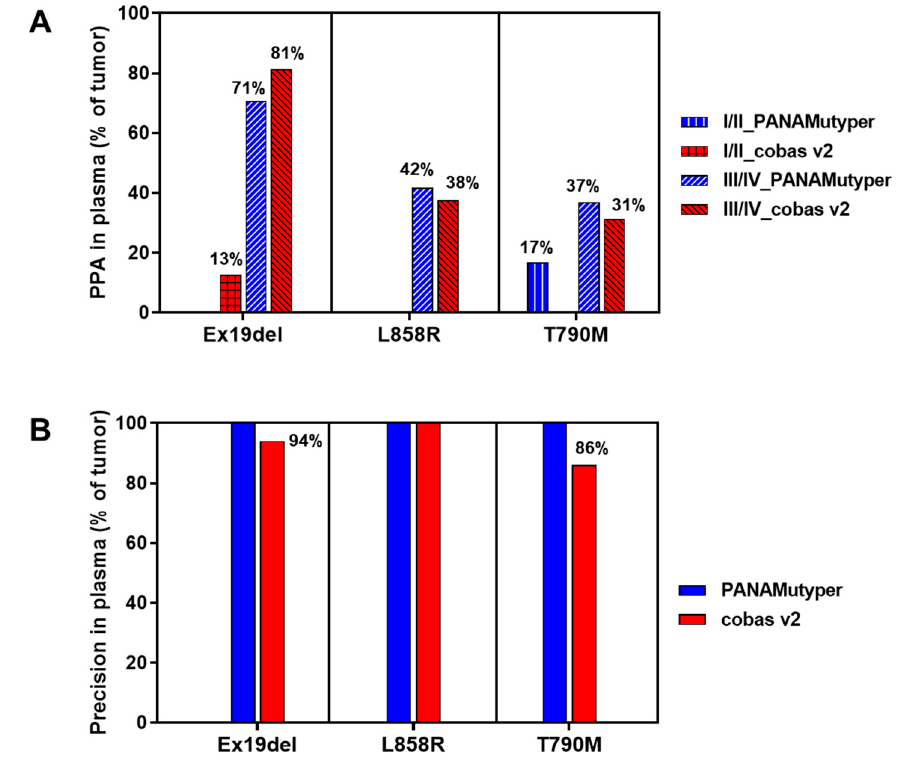
Figure 2. Detection of three EGFR mutations in plasma samples. ( A ) PPA of the two tests in plasma, stratified by disease stage. PPA is calculated as percentage of mutations detected in tumor that are also detected in plasma. ( B ) Precision of the two tests in plasma for all disease stages. Precision is calculated as the percentage of mutations detected in plasma that are also detected in tumor. PPA, positive percentage agreement; EGFR, epidermal growth factor receptor.